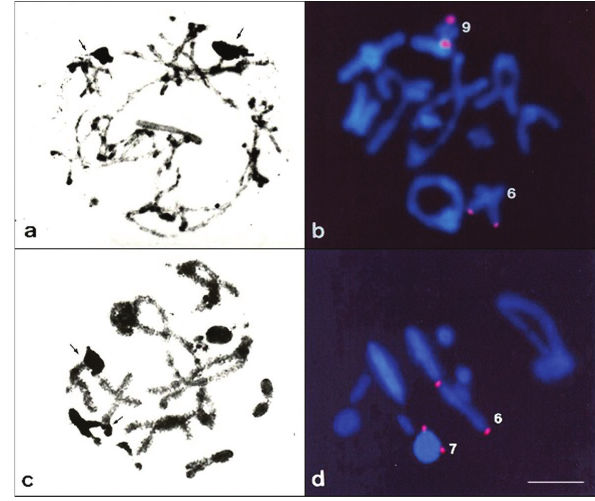
Figure 2 - Distribution pattern and characterization of CH by C-banding (a,c) and CMA 3 /DA staining (b,d) in diplotenes of O. rufipes (a,b) and E. fusiformis (c,d). Note the chromosomes with CMA 3 -positive blocks in (b) and (d). Bar = 5 (cid:2) m.